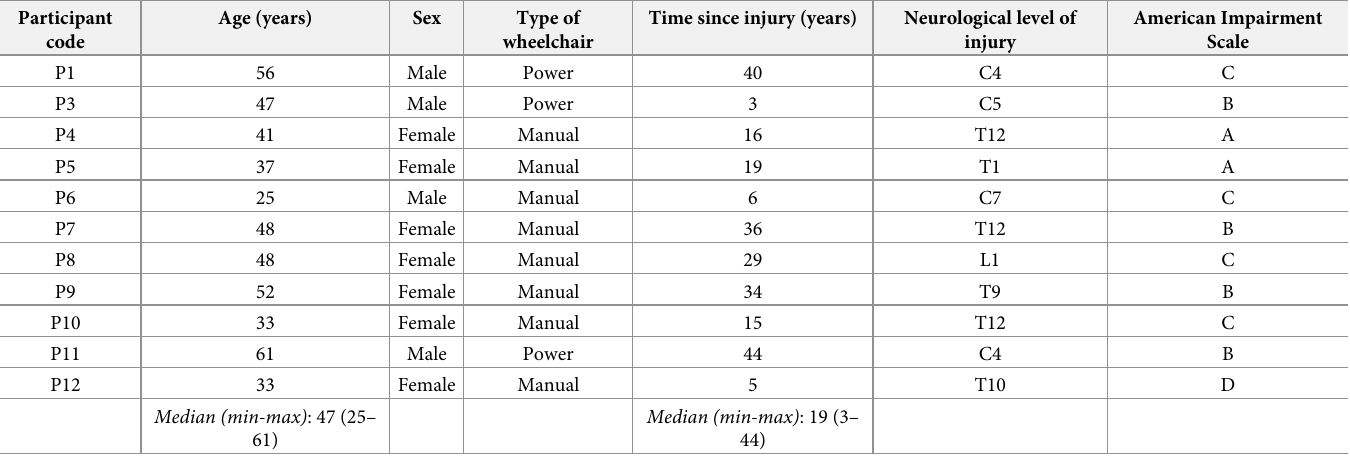
Table 3. Demographic and impairment characteristics of participants from phase